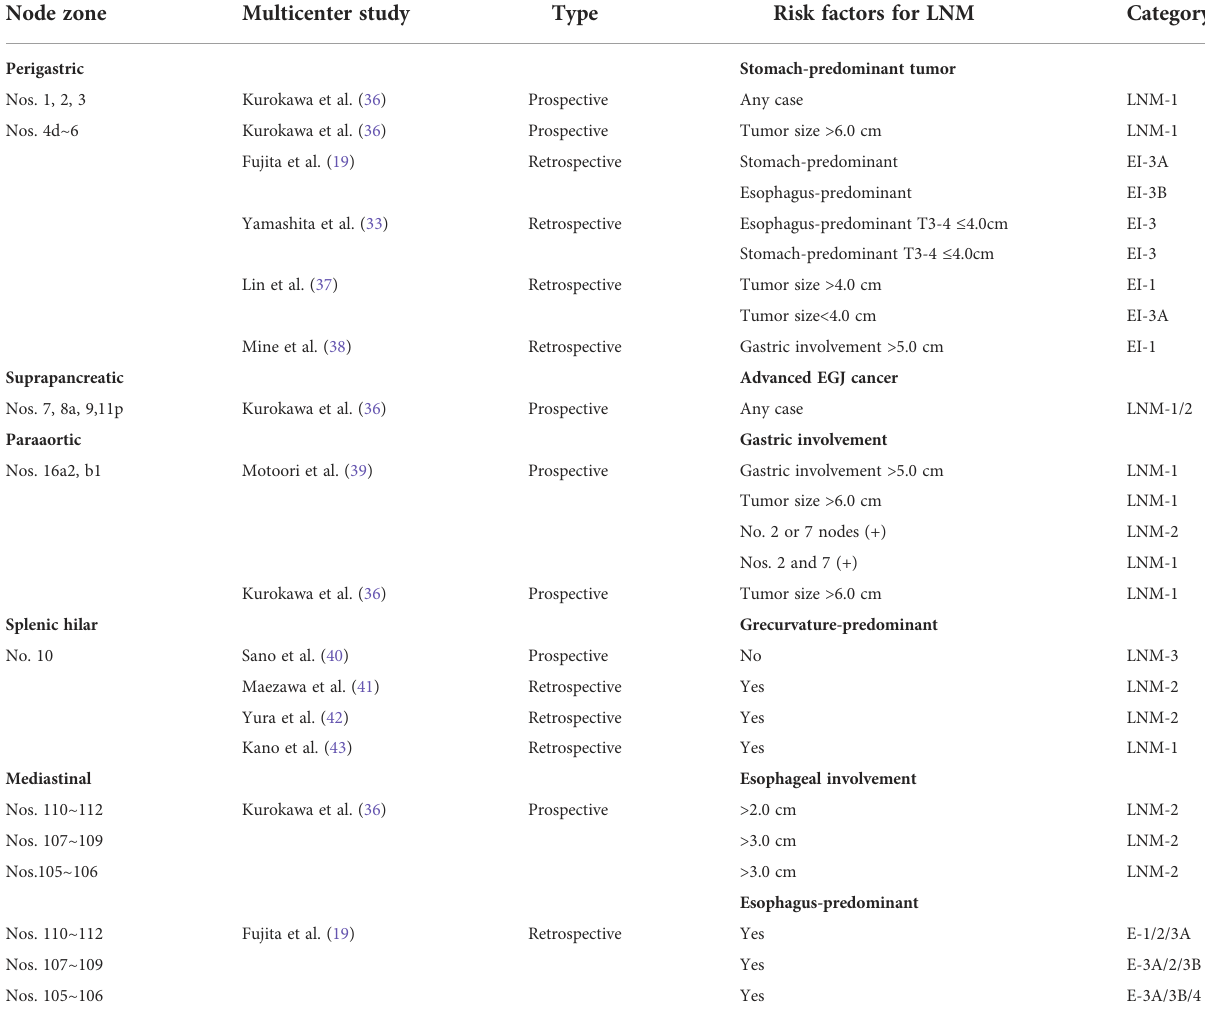
TABLE 4 The optional stations for lymph node dissection based on the epicenter location and tumor extension. Node